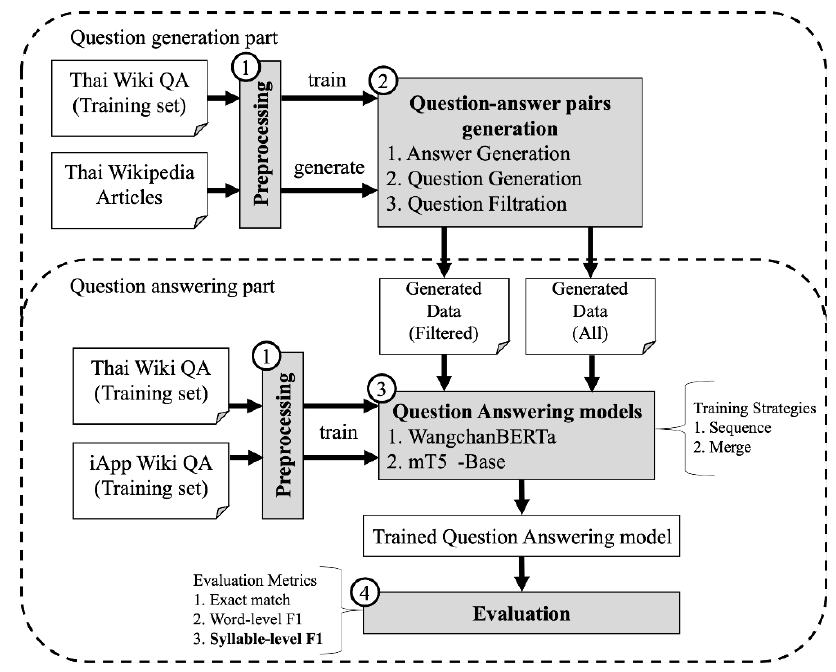
Figure 3. Illustration of the proposed overall QA framework.